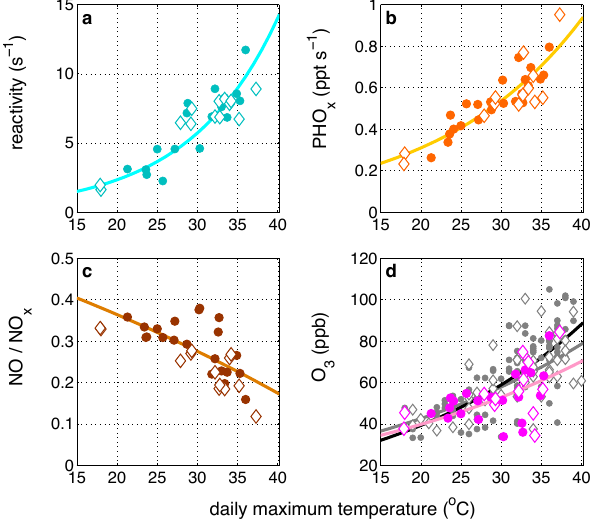
Fig. 5. (a) Total VOCR (s − 1 ) (measured OH reactivity minus the OH reactivity contributions of NO 2 , NO, HONO, HNO 3 , NH 3 , and SO 2 ; this is equivalent to the sum of the green and blue data in Fig. 2). (b) P HO x (ppts − 1 ). (c) NO/NO x . (d) O 3 (ppb) during CalNex-SJV (magenta) and in Bakersfield during the entire 2010 O 3 season (gray). All data are daily averages (10:00–14:00LT) versus daily maximum temperature ( ◦ C), are shown for weekdays (closed circles) and weekends (open diamonds), and include their exponential fits. The 2010 Bakersfield O 3 data are fit separately for weekdays (solid black line) and weekends (solid gray line).